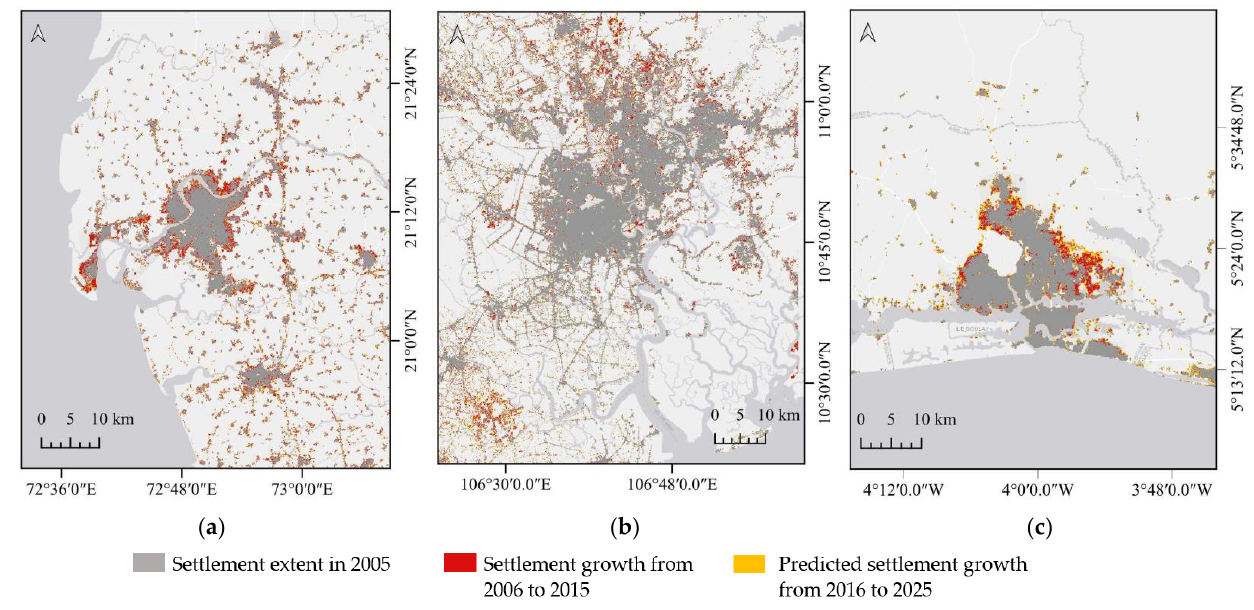
Figure 14. Predicted settlement growth of the near future based on the STM-based model: ( a ) pre-